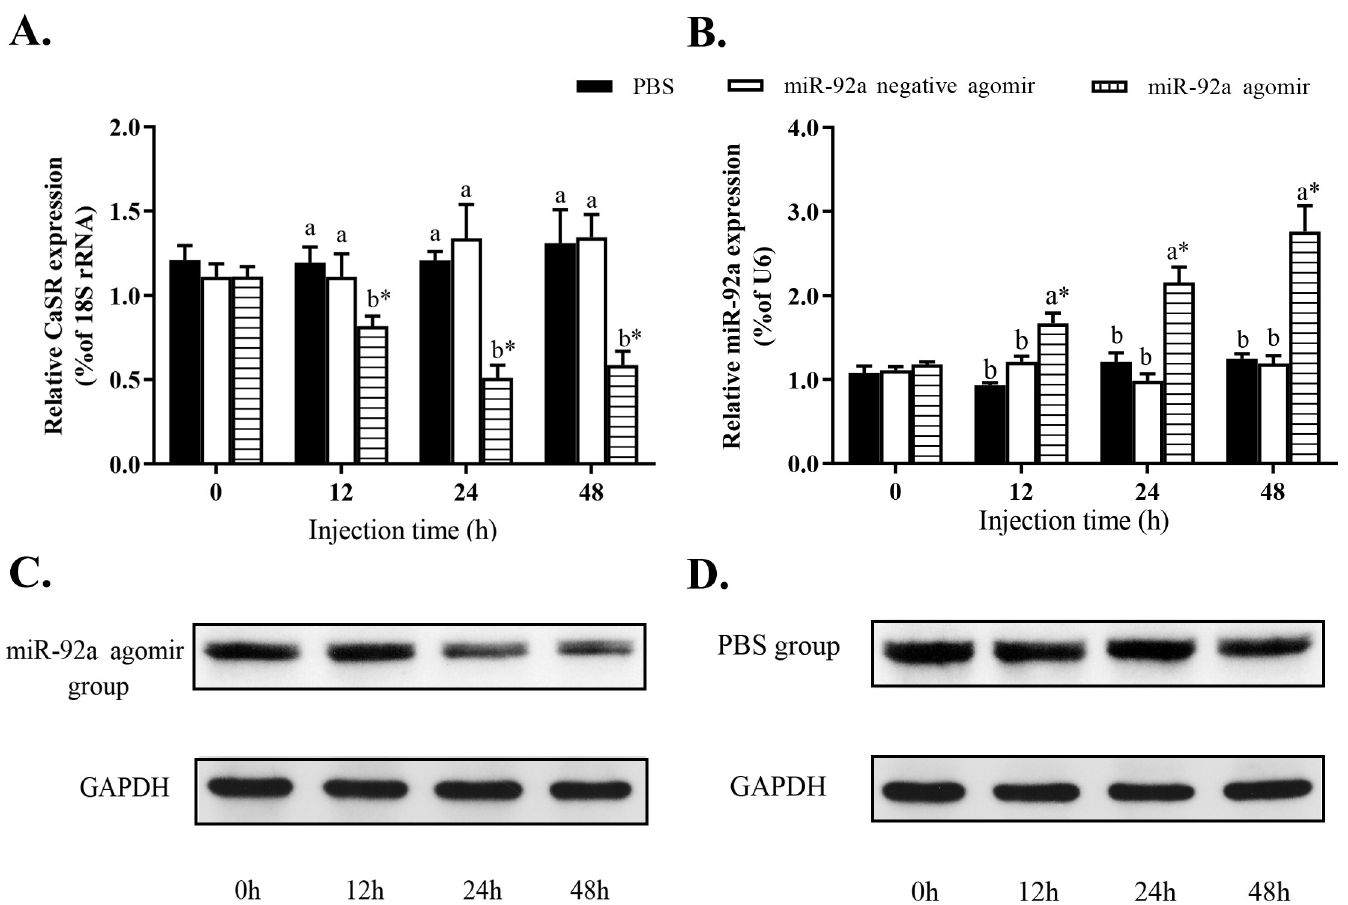
Fig 1. Analysis of regulatory relationship between CaSR (A) and miR-92a (B) in vivo . Juvenile GIFT weighing 18.4 g ± 0.8 g were injected in tail vein with miR-92a agomir (dose, 25 mg/kg body weight), miR-92a negative agomir, or PBS (control). (A, C, and D) qRT-PCR (upper panel) and western blot (lower panel) analyses of CaSR expression in GIFT after injection with miR-92a agomir. Bands of interest were cropped from the same membrane. (B) qRT-PCR analysis of miR-92a expression in GIFT after injection with miR-92a agomir. Based on relative levels in control group at 0 h, relative expression levels of mRNA and miRNA in each experimental group were determined by 2 - ΔΔ CT method. � Indicates significant difference between pre- and post- injection in the same experimental group (Independent samples t test; P < 0.05). Different lowercase letters indicate significant differences among different treatments at each sampling point (Duncan’s multiple range test; P < 0.05).